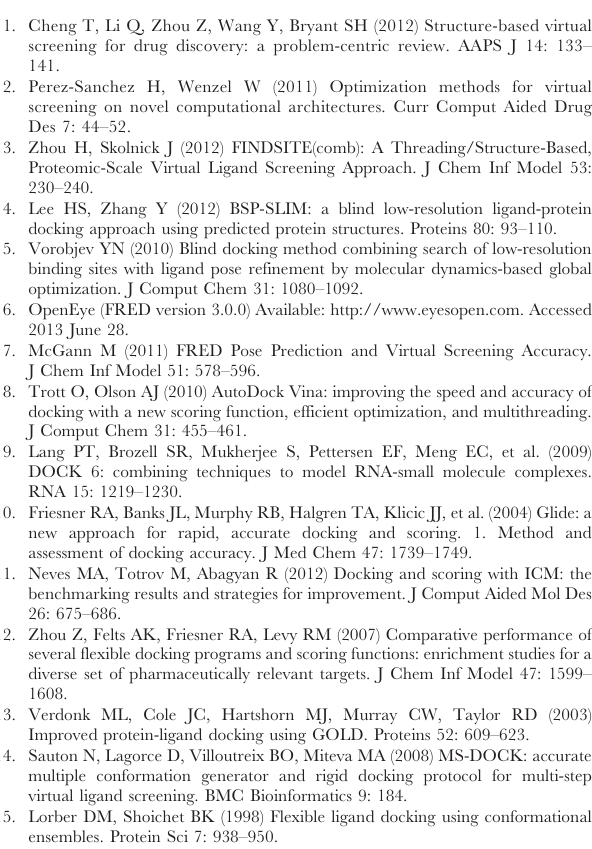
Figure S1 Dependence of simulation time on number of rays. A single ligand conformation was docked in the Bcl-xL ( A– C ) or Mdm2 ( D–F ) surface pocket, independently varying the number of rays defining the pocket and the number of